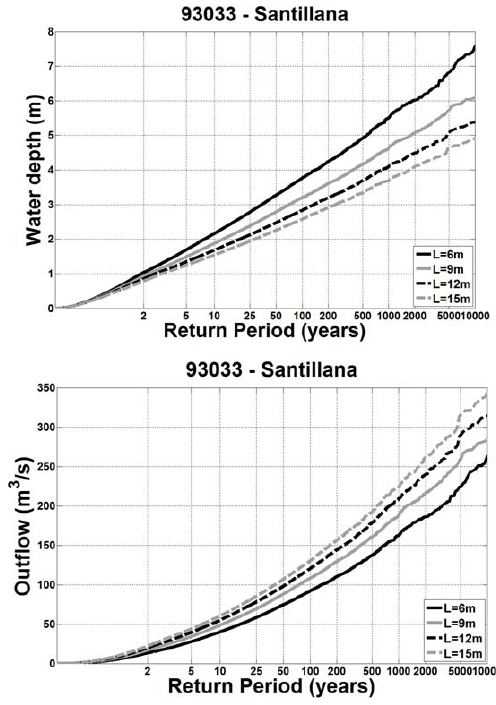
Fig. 11. Frequency curves of the water depth over the spillway crest and release for different lengths of the spillway crest in the Santil- lana